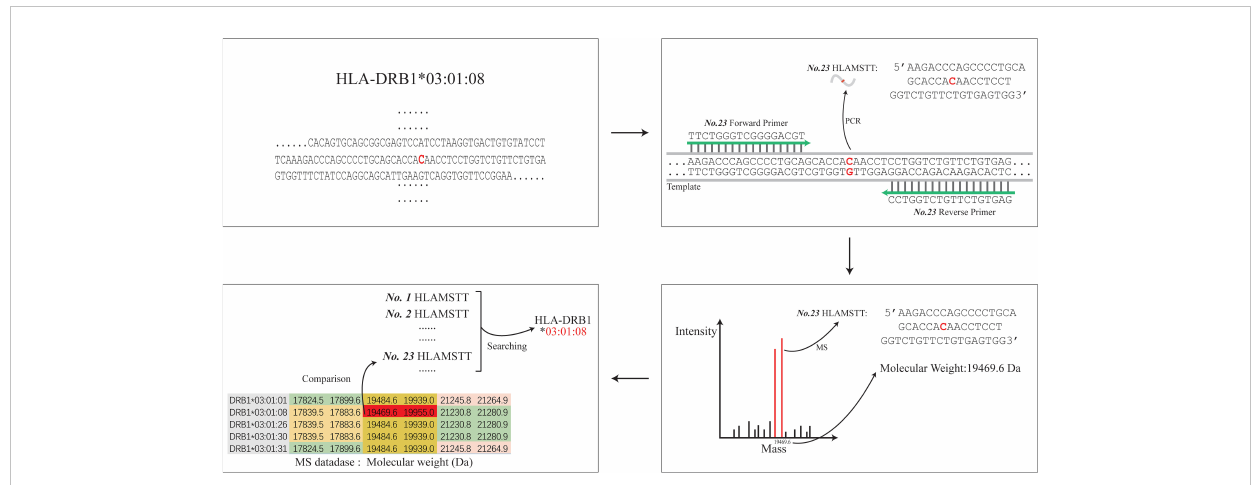
FIGURE 1 The schematic diagram of HLA MS typing. HLA MS typing software was used to perform SNP analysis of an HLA sample sequence and design PCR primers. Numerous PCR products containing SNPs were ampli fi ed and their molecular weights were obtained by MS analysis. The molecular weights from the experiments were used to interrogate the HLA MS database, and the typing result was eventually generated according to the search typing